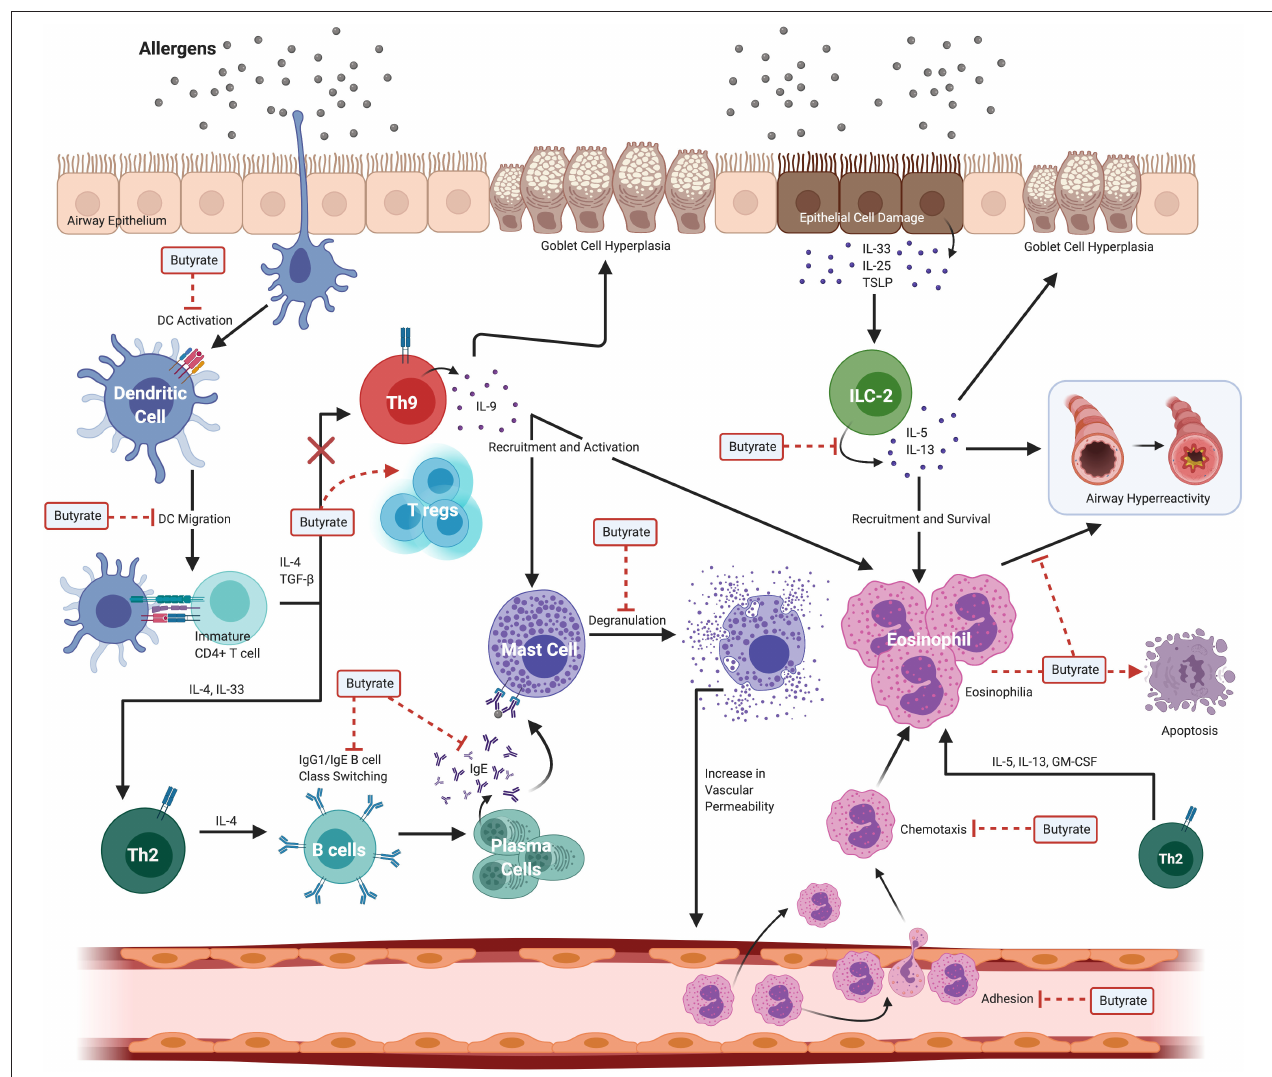
FIGURE 3 | Widespread effects of butyrate on immune cells in allergic asthma. Allergic asthma is a complex inflammatory disease with several immune cells involved in the pathogenesis. Exposure to an allergen induces eosinophilia, airway hyperreactivity, and goblet cell hyperplasia. These effects are collectively driven by dendritic cells (DCs), Th2 cells, Th9 cells, ILC2s, B cells, mast cells, and eosinophils. Butyrate ameliorates allergic asthma by modulating various steps in pathways of different immune cell compartments. Butyrate suppresses both DC activation and migration to local lymph nodes where activated DCs function to stimulate immature/naive CD4 + T cells to polarize to the Th2 lineage. In the B cell compartment, butyrate suppresses both B cell isotype class switching and plasma cell differentiation leading to decreased levels of circulating IgE. Subsequent binding of allergens and cross-linking of surface bound IgE to Fc receptors expressed on mast cells induces degranulation; however, butyrate inhibits IgE-mediated mast cell degranulation. In the Th9 cell lineage, butyrate functions to divert the fate of naïve CD4 + T cells from Th9 to FoxP3 + regulatory-T cells (T regs) effectively promoting a regulatory phenotype. In ILC2s, butyrate suppresses the secretion of IL-5 and IL-13 cytokines